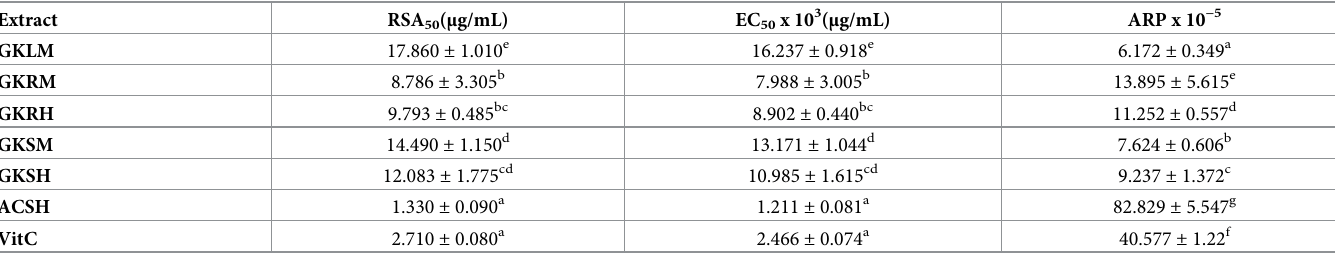
Table 4. 50% Radical scavenging activity (RSA 50 ) and 50% efficient concentration (EC 50 ) and anti-radical power against ABTS radical.